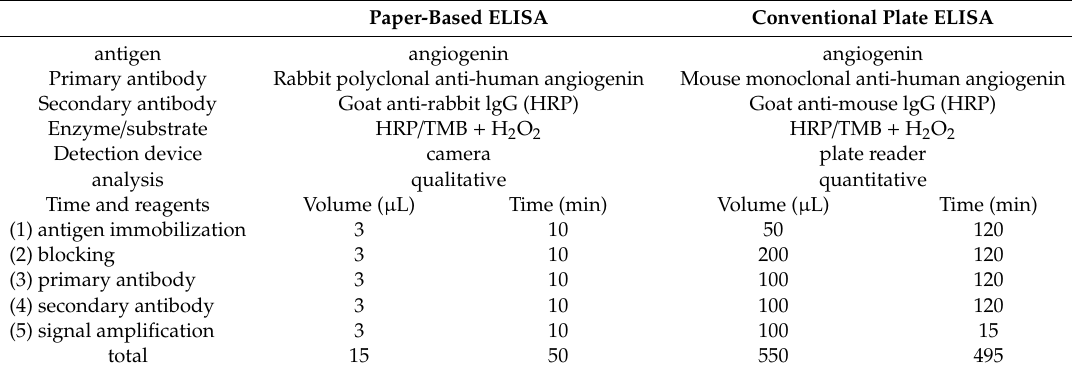
Table 1. Comparison of paper-based ELISA and conventional plate ELISA. Paper-Based